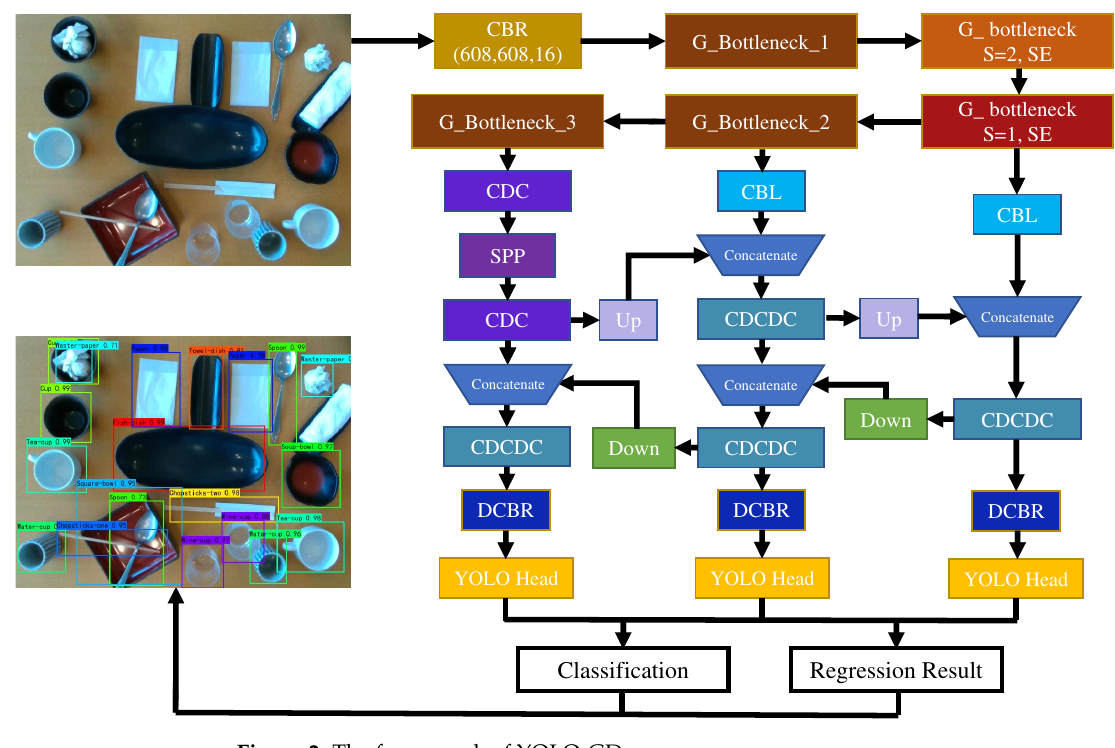
Figure 2. The framework of YOLO-GD.